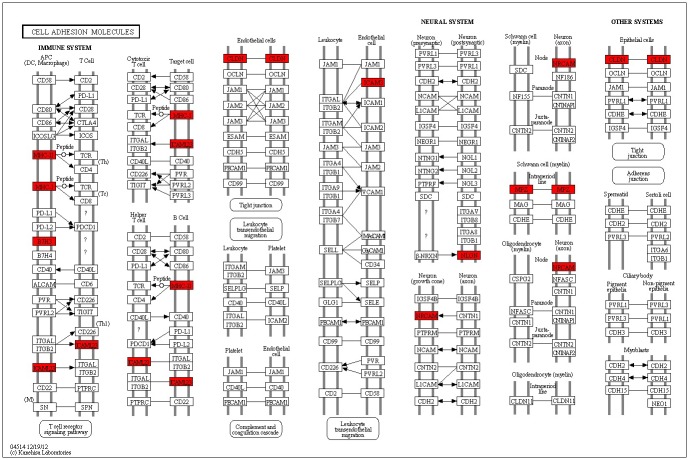
Genes involved in ‘cell adhesion molecules’ pathway.Color scheme: Red = significant genes (P<0.01). White = non-significant genes. See detail in (http://www.genome.jp/kegg-bin/show_pathway?hsa04514).